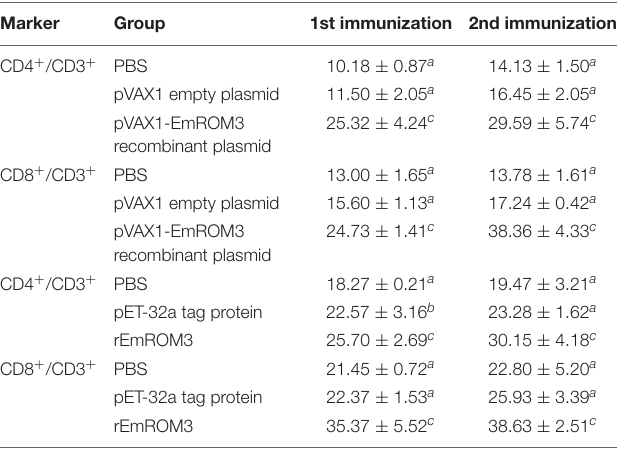
TABLE 3 | The proportion of T cell subpopulation in the spleen of immunized